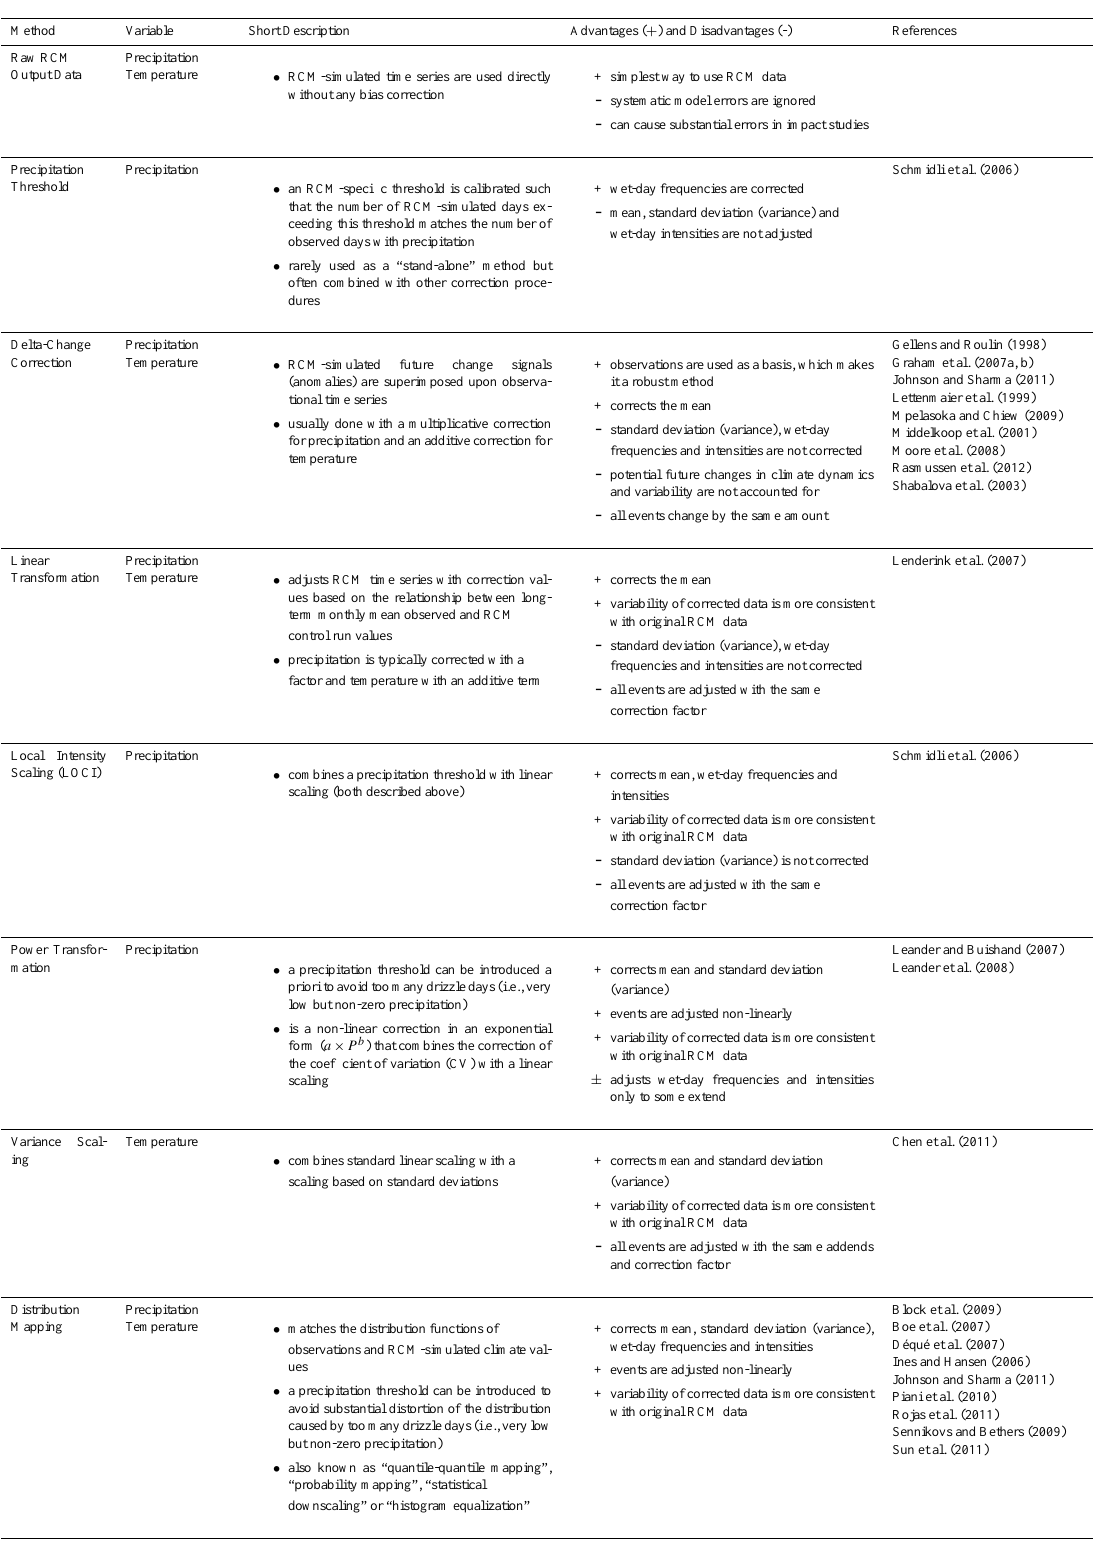
Table 4. Overview of methods used to correct RCM-simulated precipitation and/or temperature data, for more information on the methods see Teutschbein and Seibert (2012) and the specified